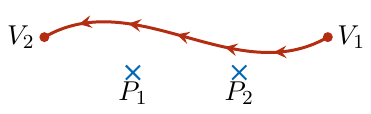
Figure 2 . Any 1 -simplex contour and a pair of singularity points in CP 1 yields a